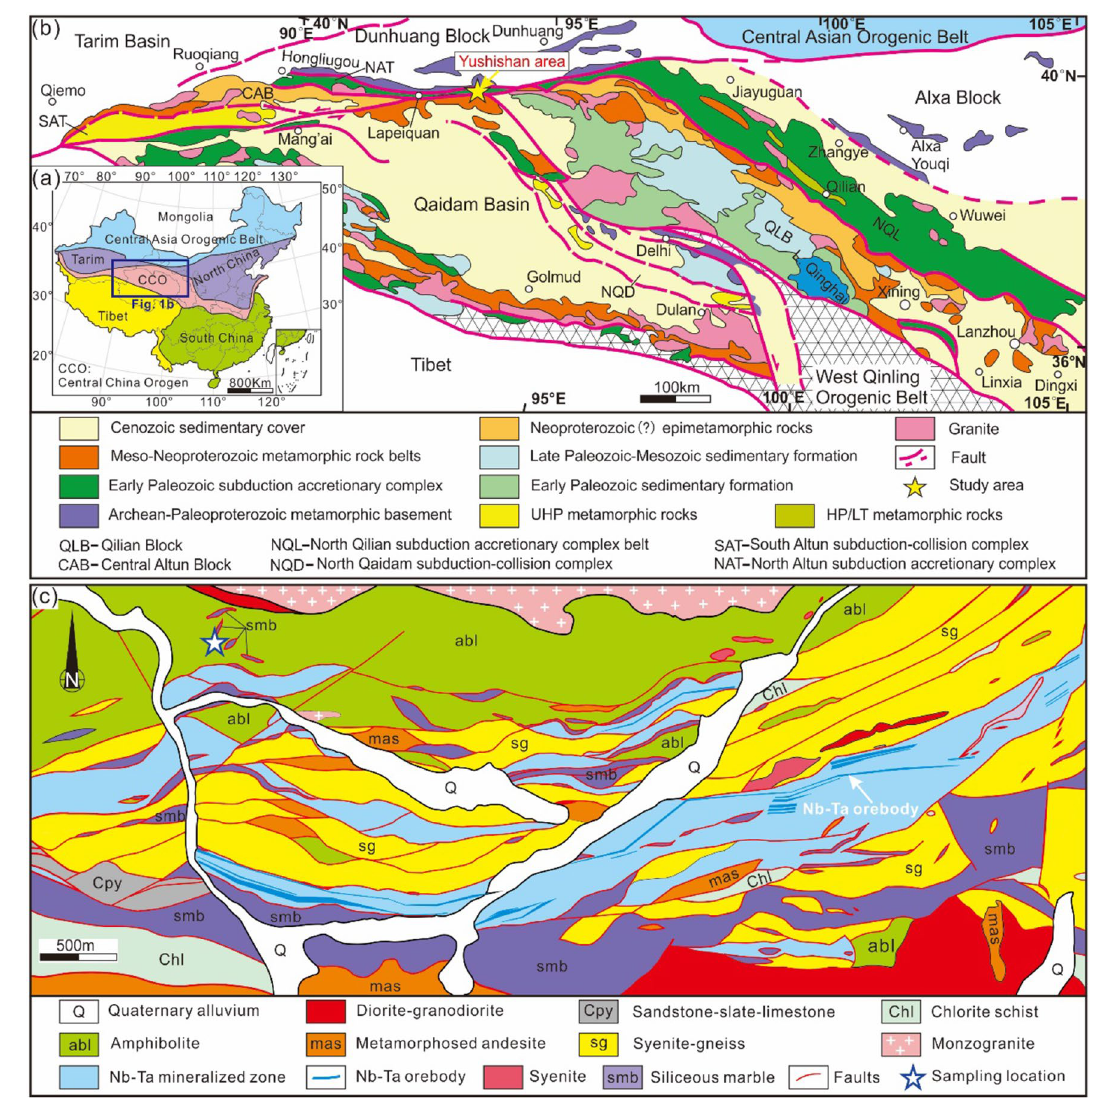
Figure 1. Geological map. ( a ) Simplified geological map of China (modified from Yu et al. 41 ). ( b ) Geological sketch map of the Altun–Qilian–Kunlun (AQK) orogenic system in northern Tibet (modified from Zhang et al. 42 ). ( c ) Geological map of the Yushishan Nb–Ta deposit (from the Geological Survey of Gansu Province, China). The figure was created using CorelDRAW 2018 software (https:// www. corel draw. com/ en/ pages/ corel draw- 2018/), and the map will not have a copyright